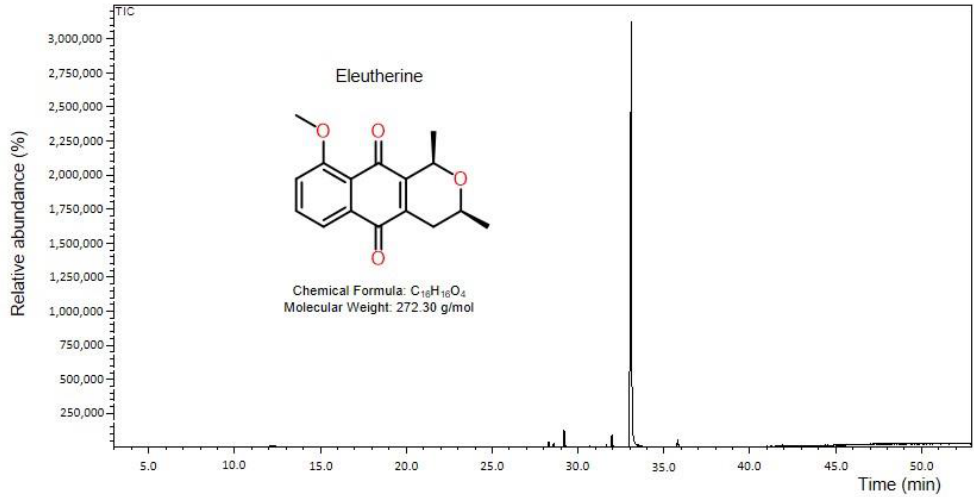
Figure 2. Chromatogram of eleutherine isolated from the bulbs of Eleutherine plicata . Peak area (95.03%) and retention time at 33.10 min.